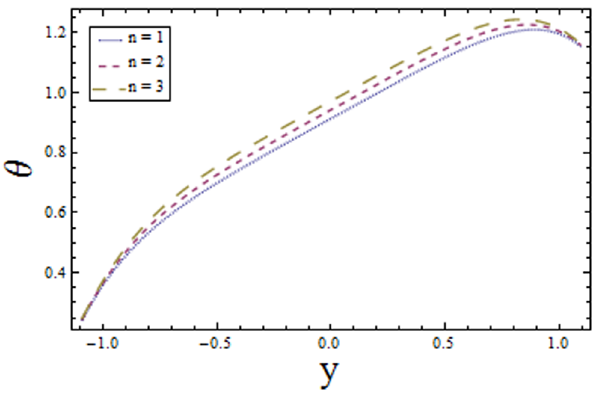
Figure 8. Plot of temperature h for power law index n with E ~ 0 : 1 , t ~ 0 : 01 , x ~ 0 : 2 , ª 1 ~ 4 , ª 2 ~ 6 , E 1 ~ 0 : 4 ,